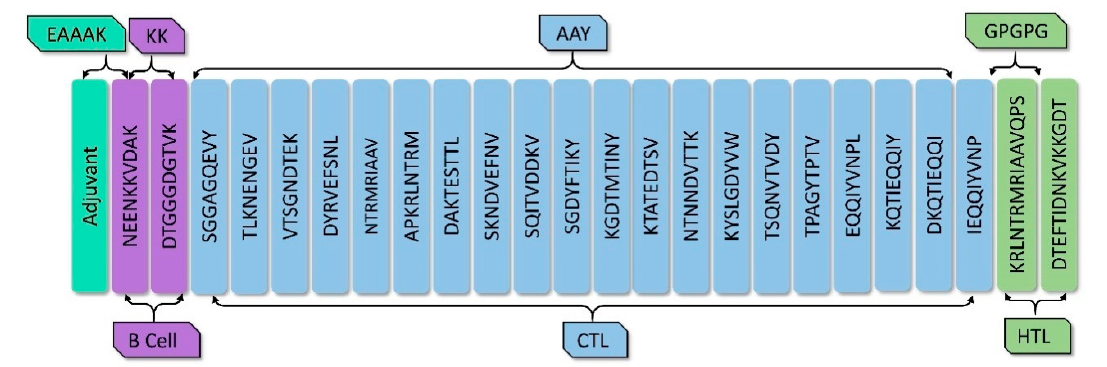
Figure 2. The structural arrangement of B- and T-cell epitopes along with linkers and adjuvant for the final multi-epitope vaccine construct.